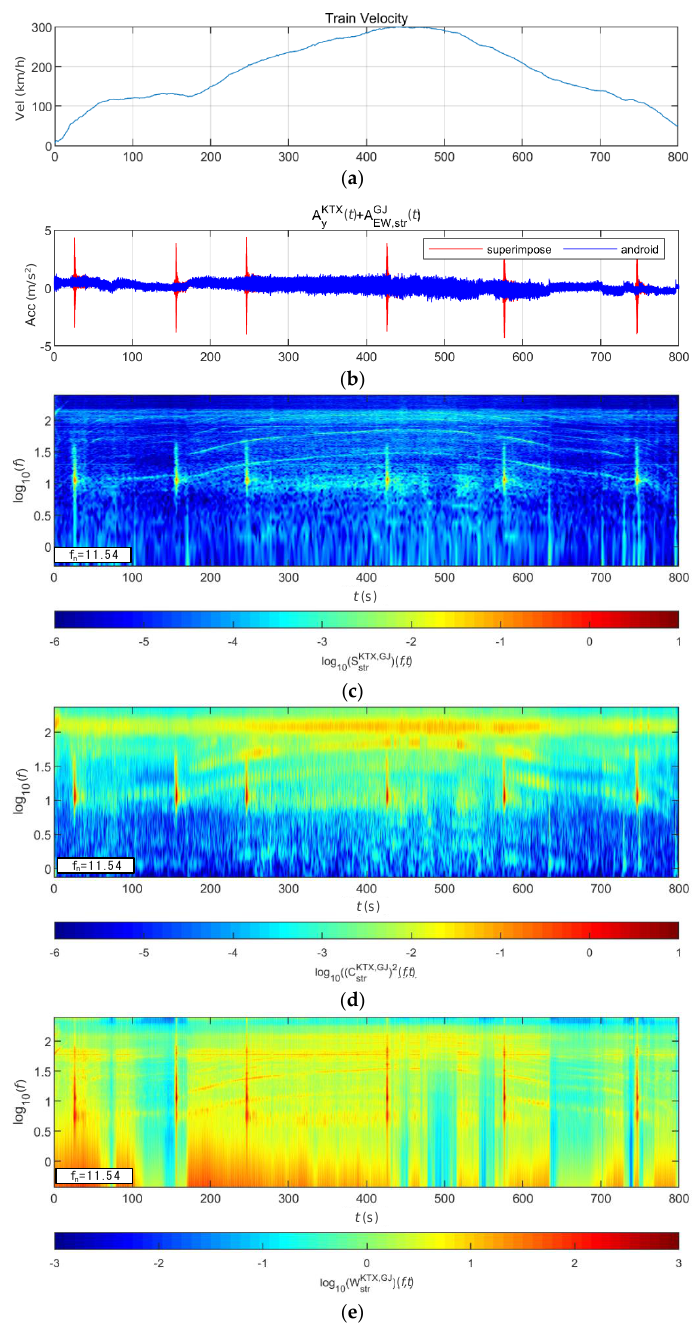
Figure 28. Combination of train data with BR2 bridge-response data from the Gyeongju earthquake (scaled to 1000-year return period): ( a ) velocity; ( b ) lateral acceleration time series; ( c ) STFT; ( d ) WT; ( e ) WVD.